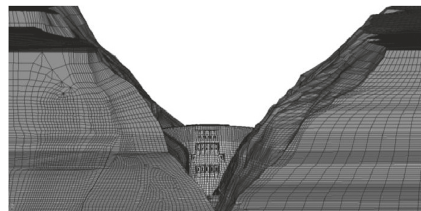
Figure 10: Three-dimensional finite element model of the Jinping-I arch dam (downstream viewpoint).